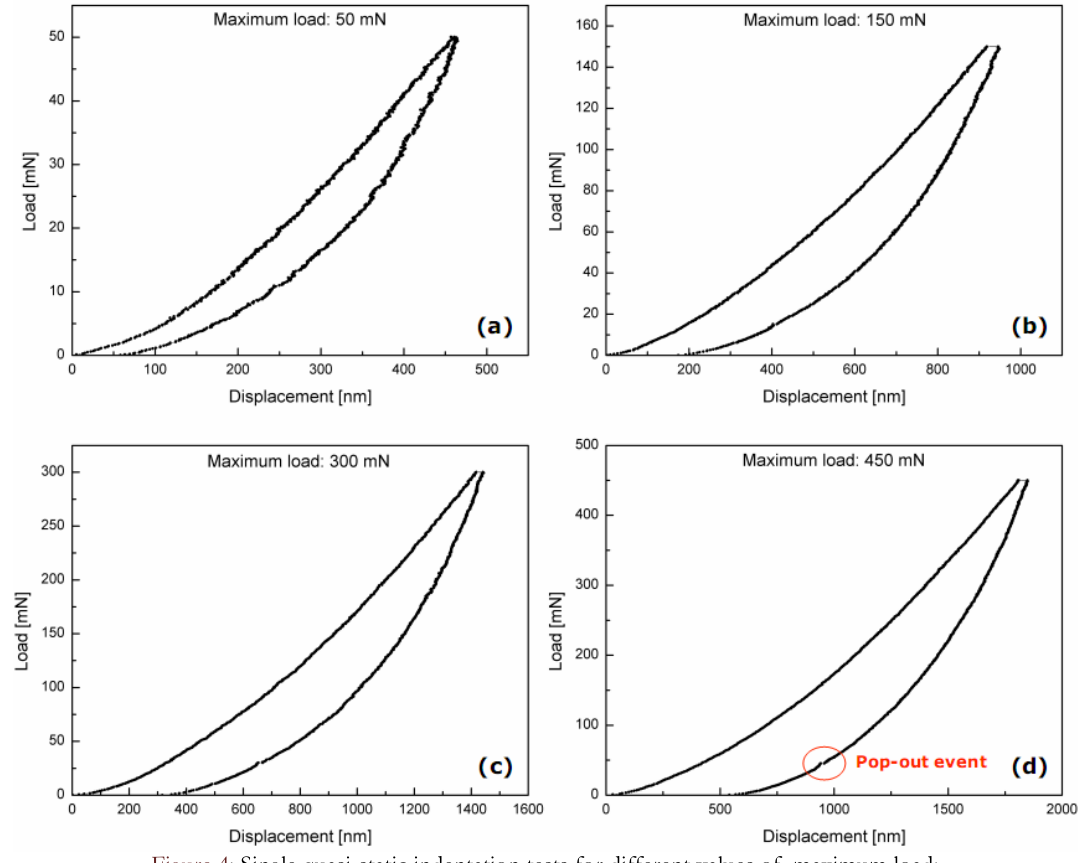
Figure 4: Single quasi-static indentation tests for different values of maximum load: